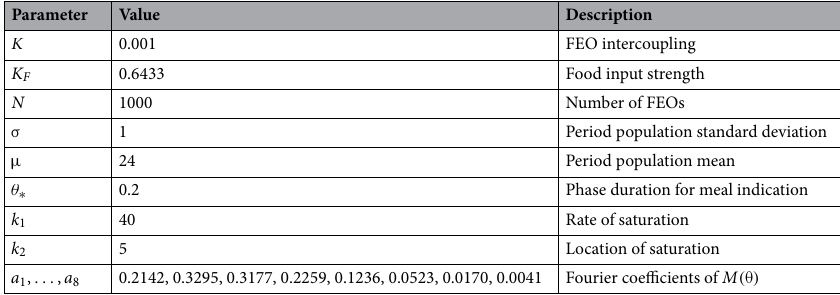
Table 1. Parameter values used in the model differential